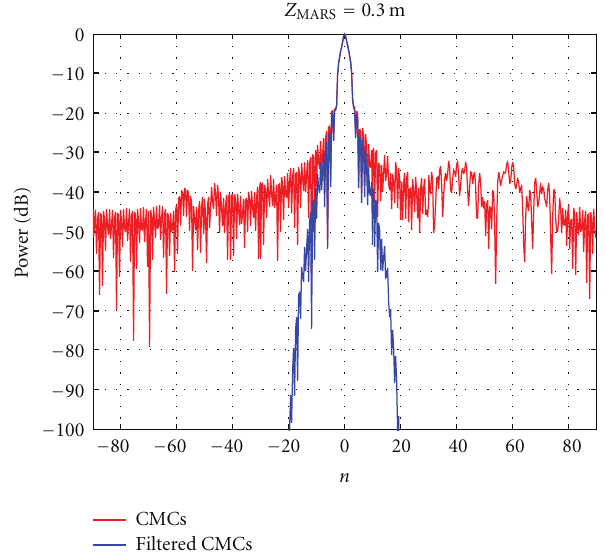
Figure 14: Equivalent CMCs with AUT displacement of 30 cm. Cosine squared filter applied.